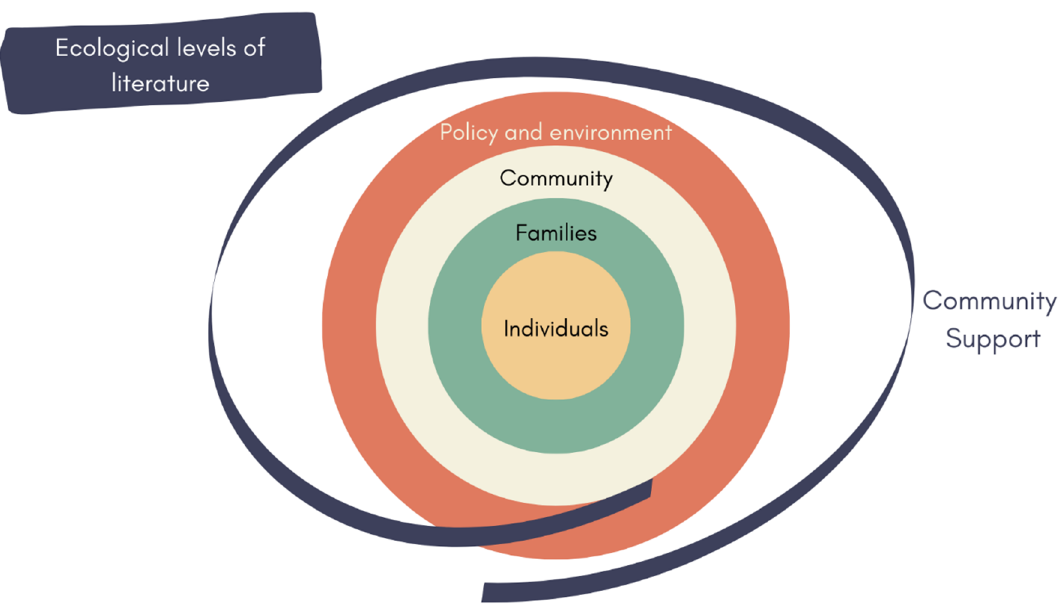
Figure 3. Ecological model according to which literature was organised.